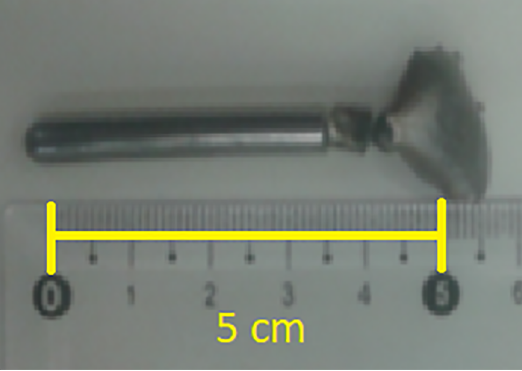
Zr Al Ag Sn suction-casted 42 42 8 4 4